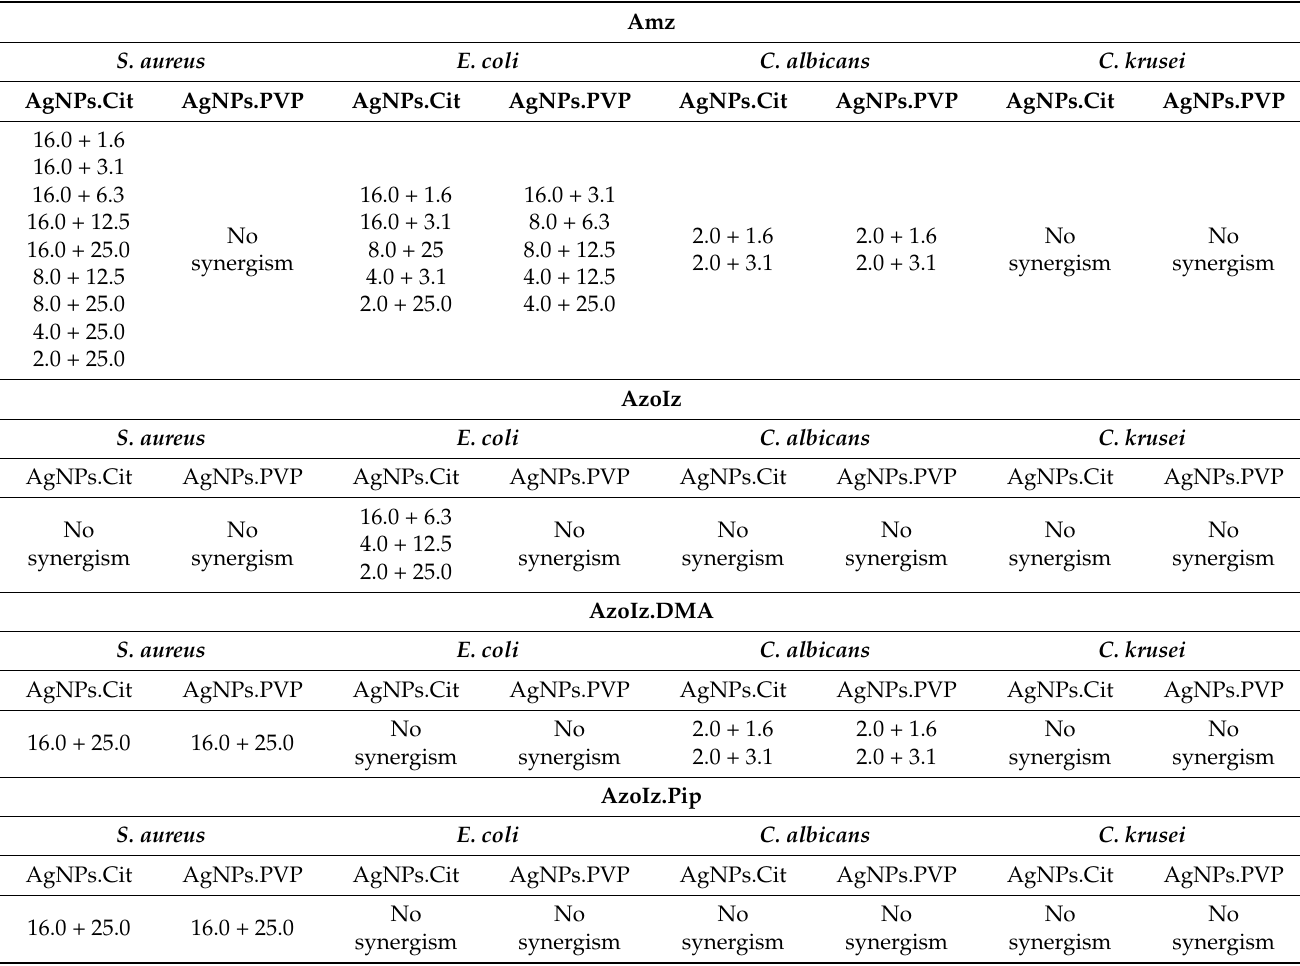
Table 3. Summary of the concentrations of organic molecules + AgNPs ( µ g · mL − 1 ) that act in synergy against bacteria and yeasts.